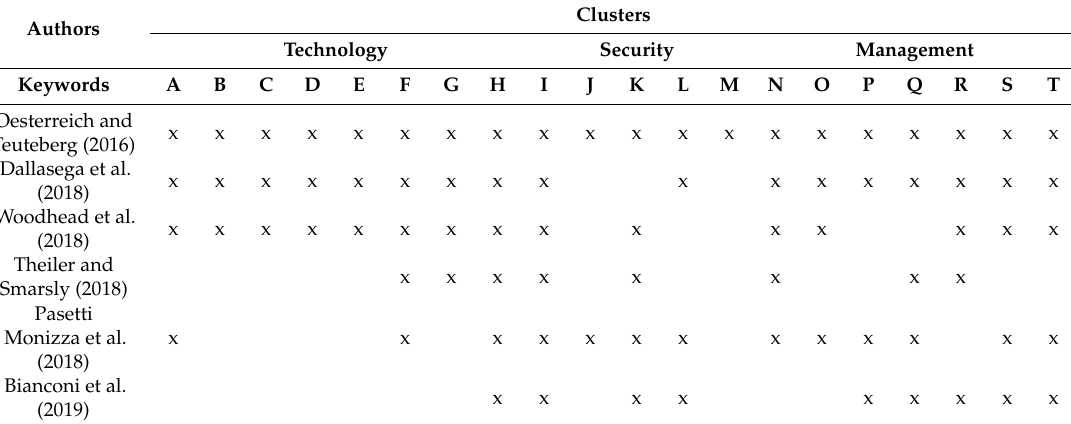
Table 9. Clustered topics discussed in 20 targeted papers (articles).